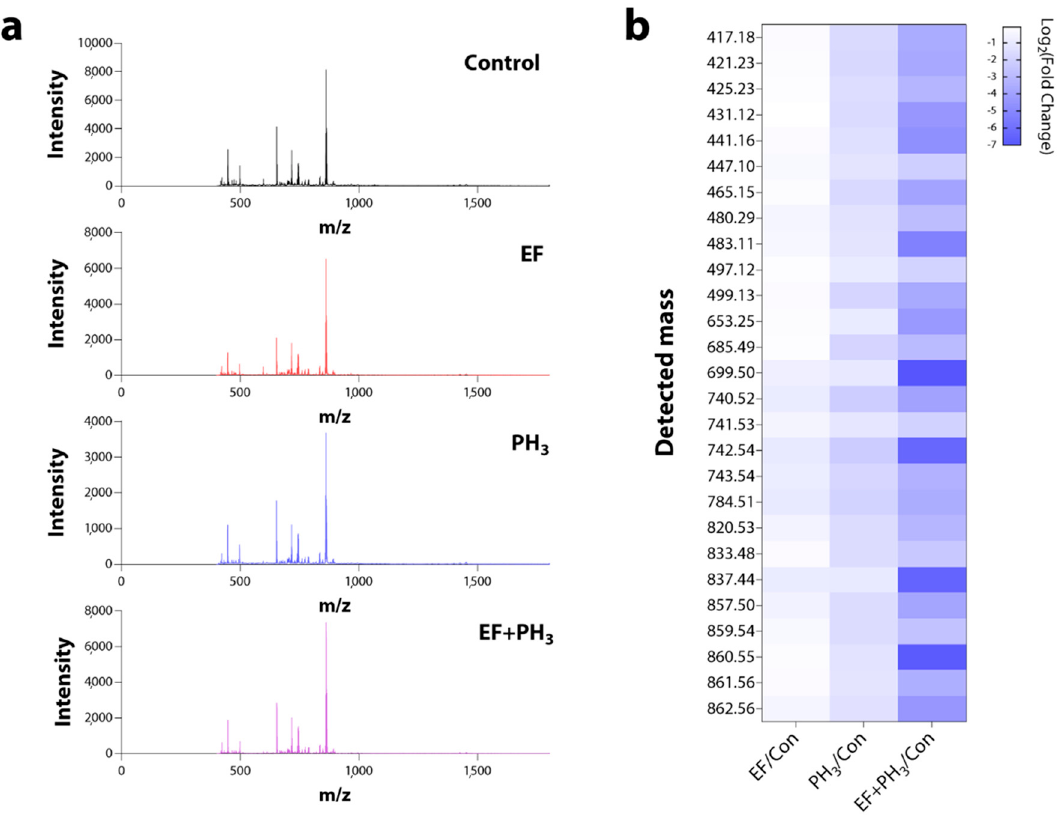
Figure 5. Mass ions for lipid profiling on P. citri adults after exposure to ethyl formate (EF), phosphine (PH 3 ), and combination treatment (EF + PH 3 ) for 4 h. ( a ) Spectrums of MALDI-TOF MS. ( b ) Pairwise analysis using a heatmap with the Kruskal − Wallis test ( p < 0.0001). A heatmap was constructed using the Log2 intensity ratio between the control and treatment groups. Table 4. List of significant lipid estimated m/z values detected using MALDI-TOF MS with the neg-